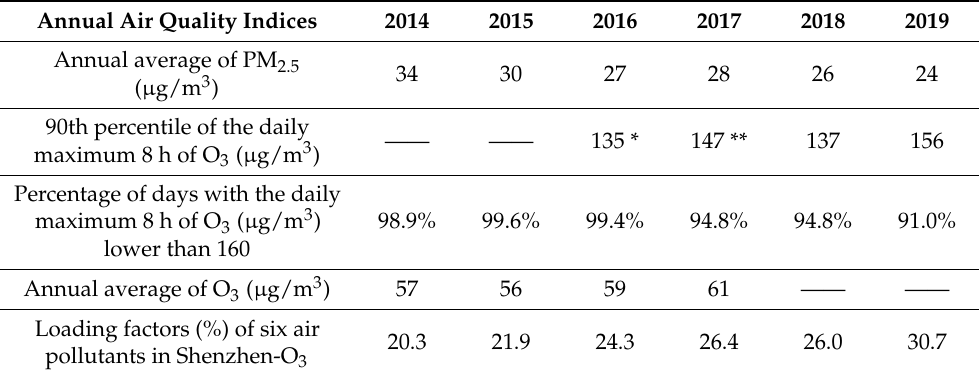
Table 1. Basic information on air quality in Shenzhen